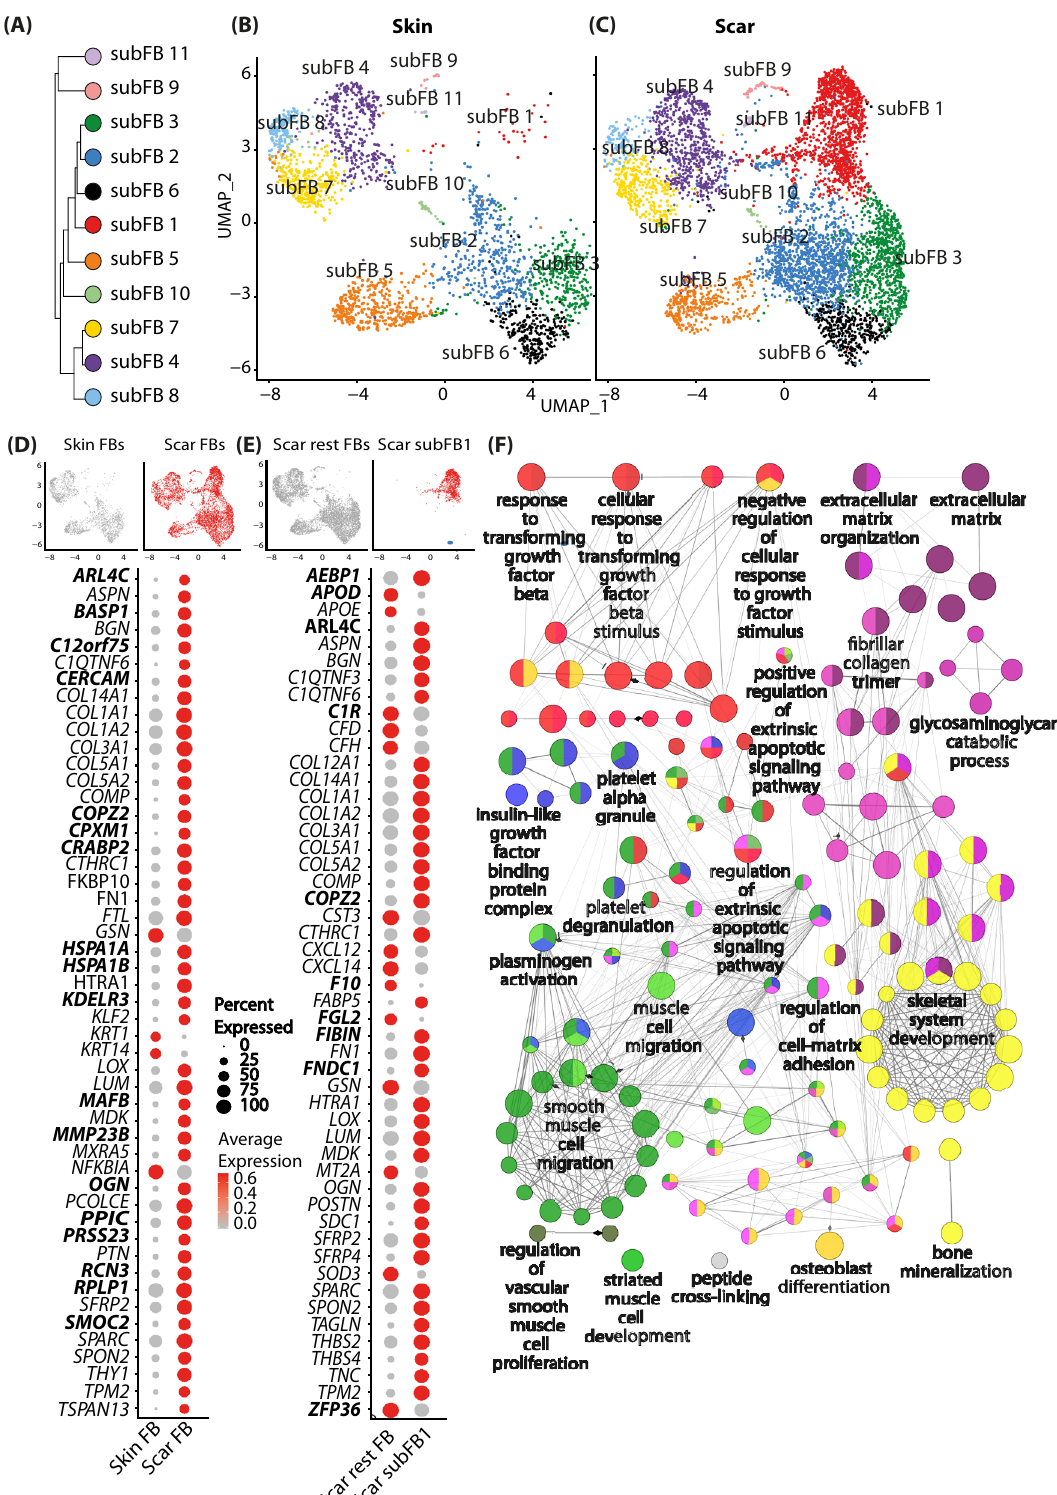
branches (Fig. 3C). Whereas the majority of FBs preferentially processes, are most upregulated at the end of Branch 2, but are aligned with branch 1 in normal skin (Fig. 3D), we observed a signi fi cantly longer branch 2 with FBs of hypertrophic scar tissue (Fig. 3E). Branched expression analysis identi fi ed genes most regulated in a pseudotime-dependent manner in normal skin and hypertrophic scars (Fig. 3F). Interestingly, the collagens COL1A1, COL1A2 , and COL3A1 , known to contribute to all fi brotic NATURE COMMUNICATIONS| (2021) 12:6242